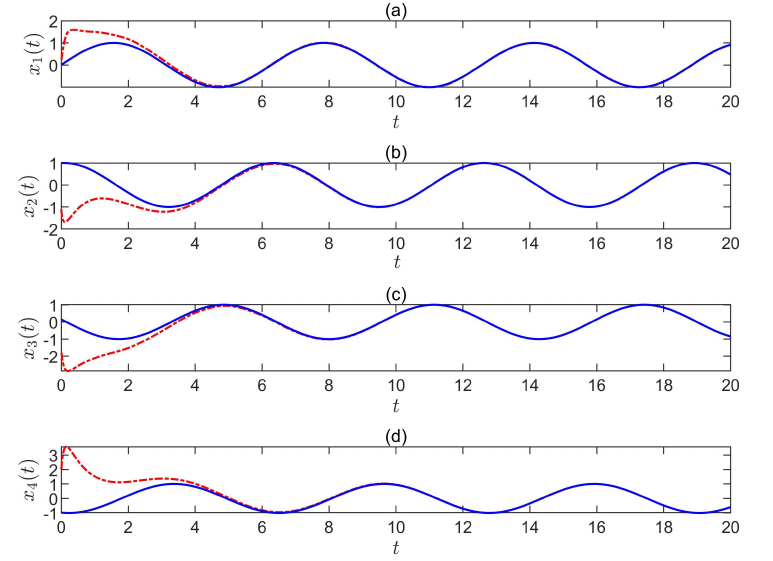
Figure 6. The state trajectories x i ( t ) , x id ( t ) of the system: ( a ) the x 1 , x 1 R − t space; ( b ) the x 2 , x 2 R − t space; ( c ) the x 3 , x 3 R − t ; ( d ) the x 4 , x 4 R − t space.